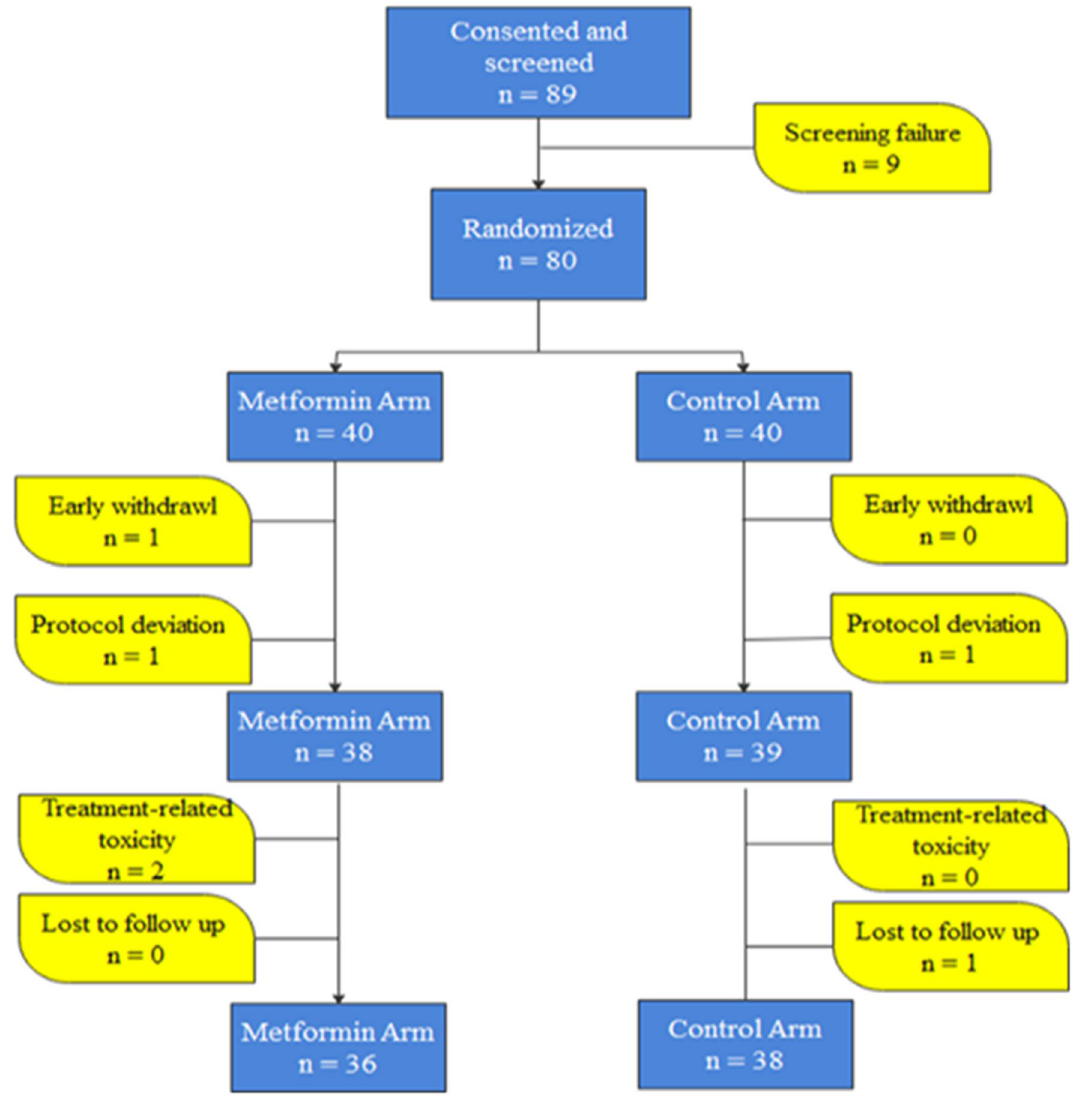
Figure 1. The CONSORT diagram illustrating the organization of the patients in the